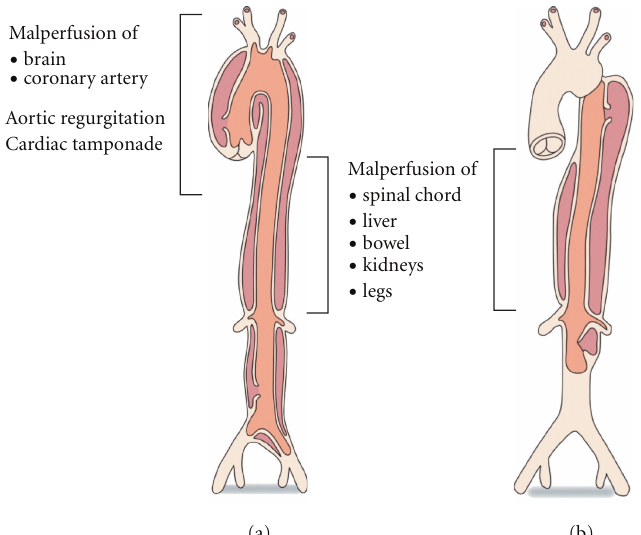
Figure 1: Subtypes and complications of aortic dissection, (a) type A and (b) type B aortic dissections. Type A encompasses Debakey I (ascending aorta only and therefore less potential for malperfusion phenomena) and II and type B Debakey III classifications. Reproduced with permission from Golledge and Eagle [4].